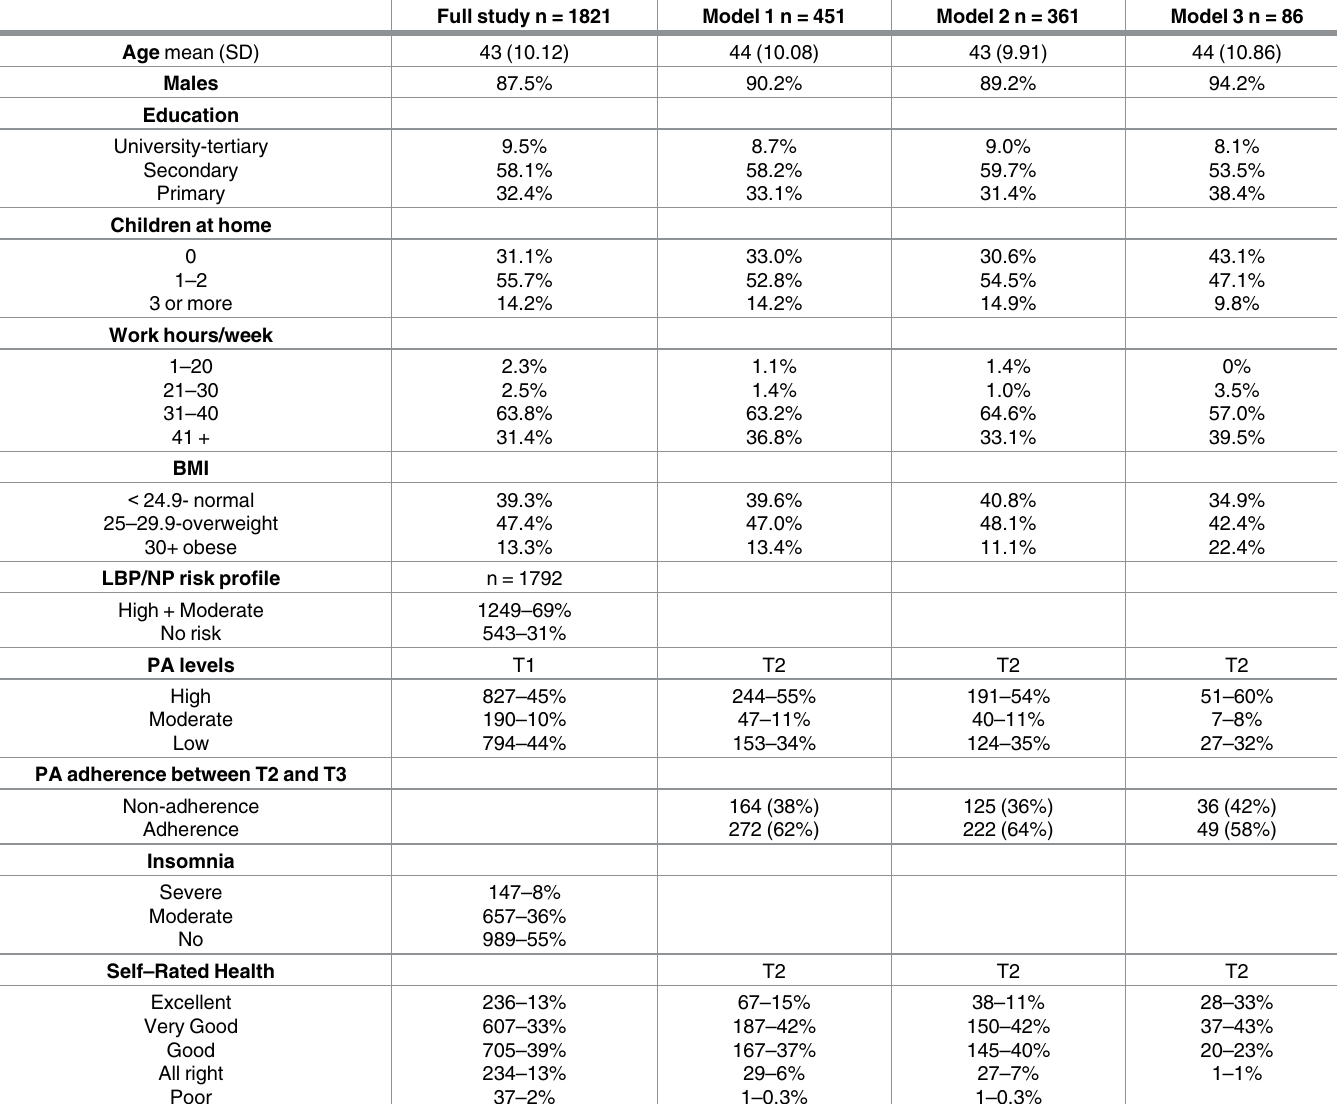
Table 4. Baseline information about the source population and the selected